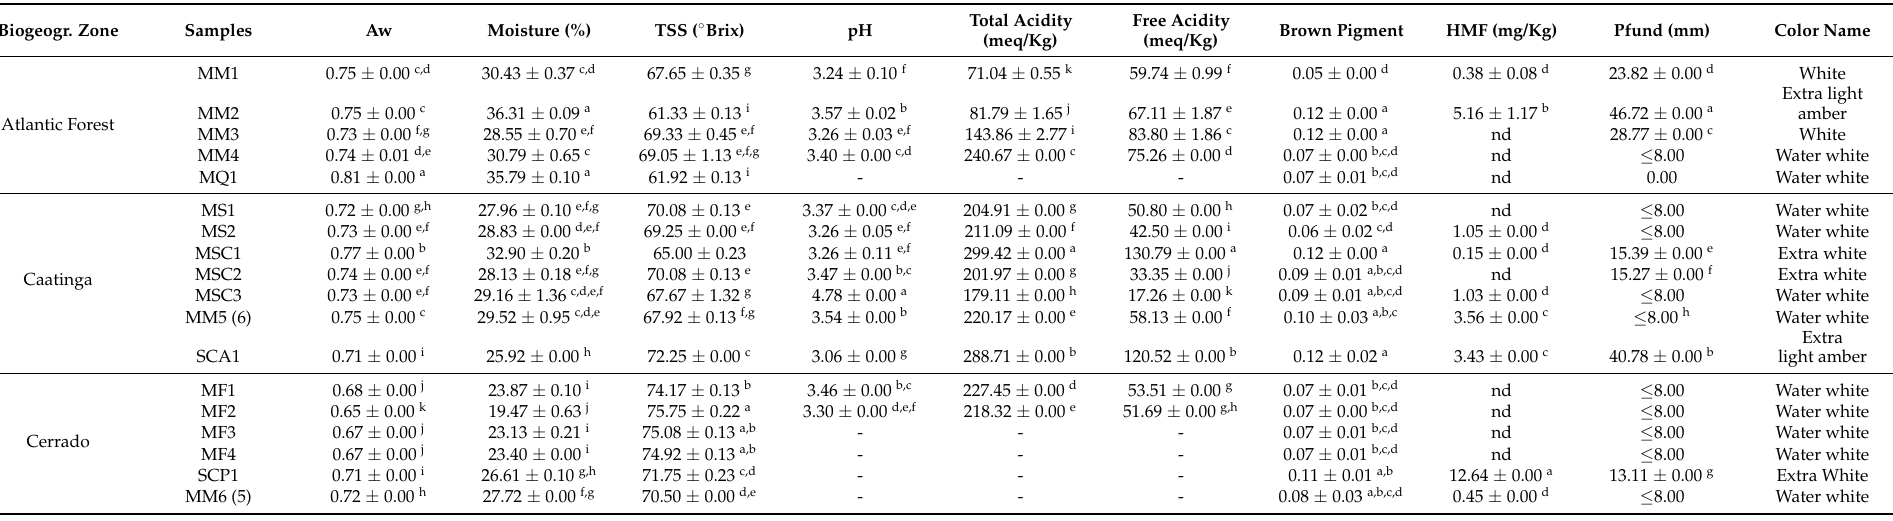
Table 2. Physicochemical parameters of honey produced by stingless bees from different Brazilian biogeographical zones. Biogeogr.